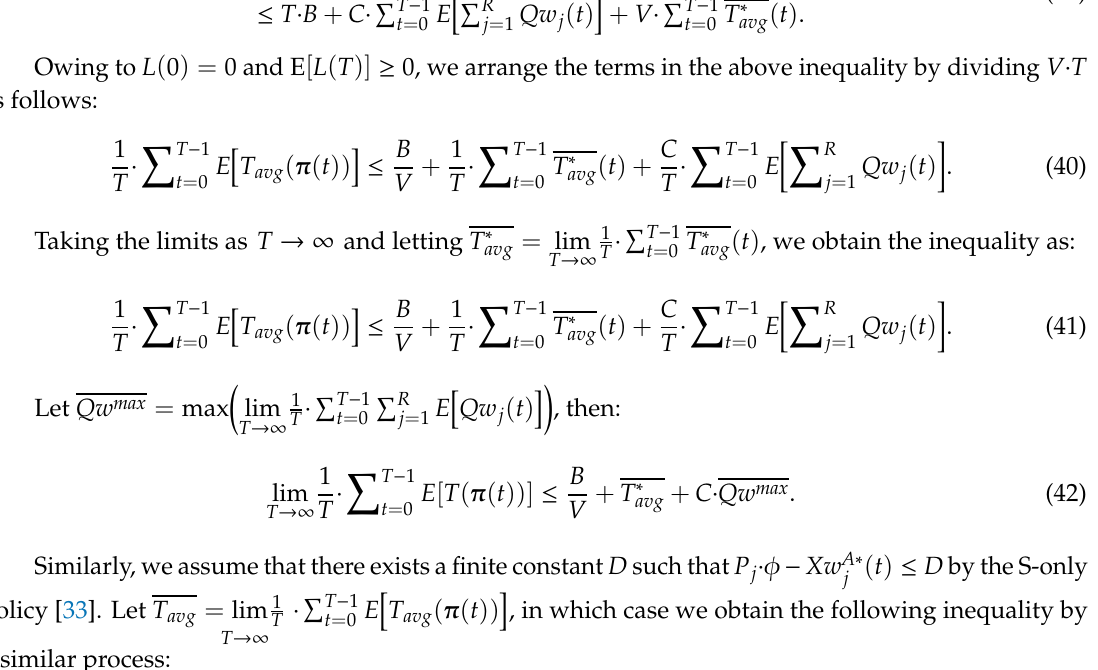
Table 1. Based on [37], we also use the Poisson distribution with the vector λ ( t ) = representing the expected number of arrivals to model the task generation rate of the end tier in the three regions. For each time slot, the length of the corresponding task instruction (million instructions, MI) follows an exponential distribution with an expected length vector l ( t ) =